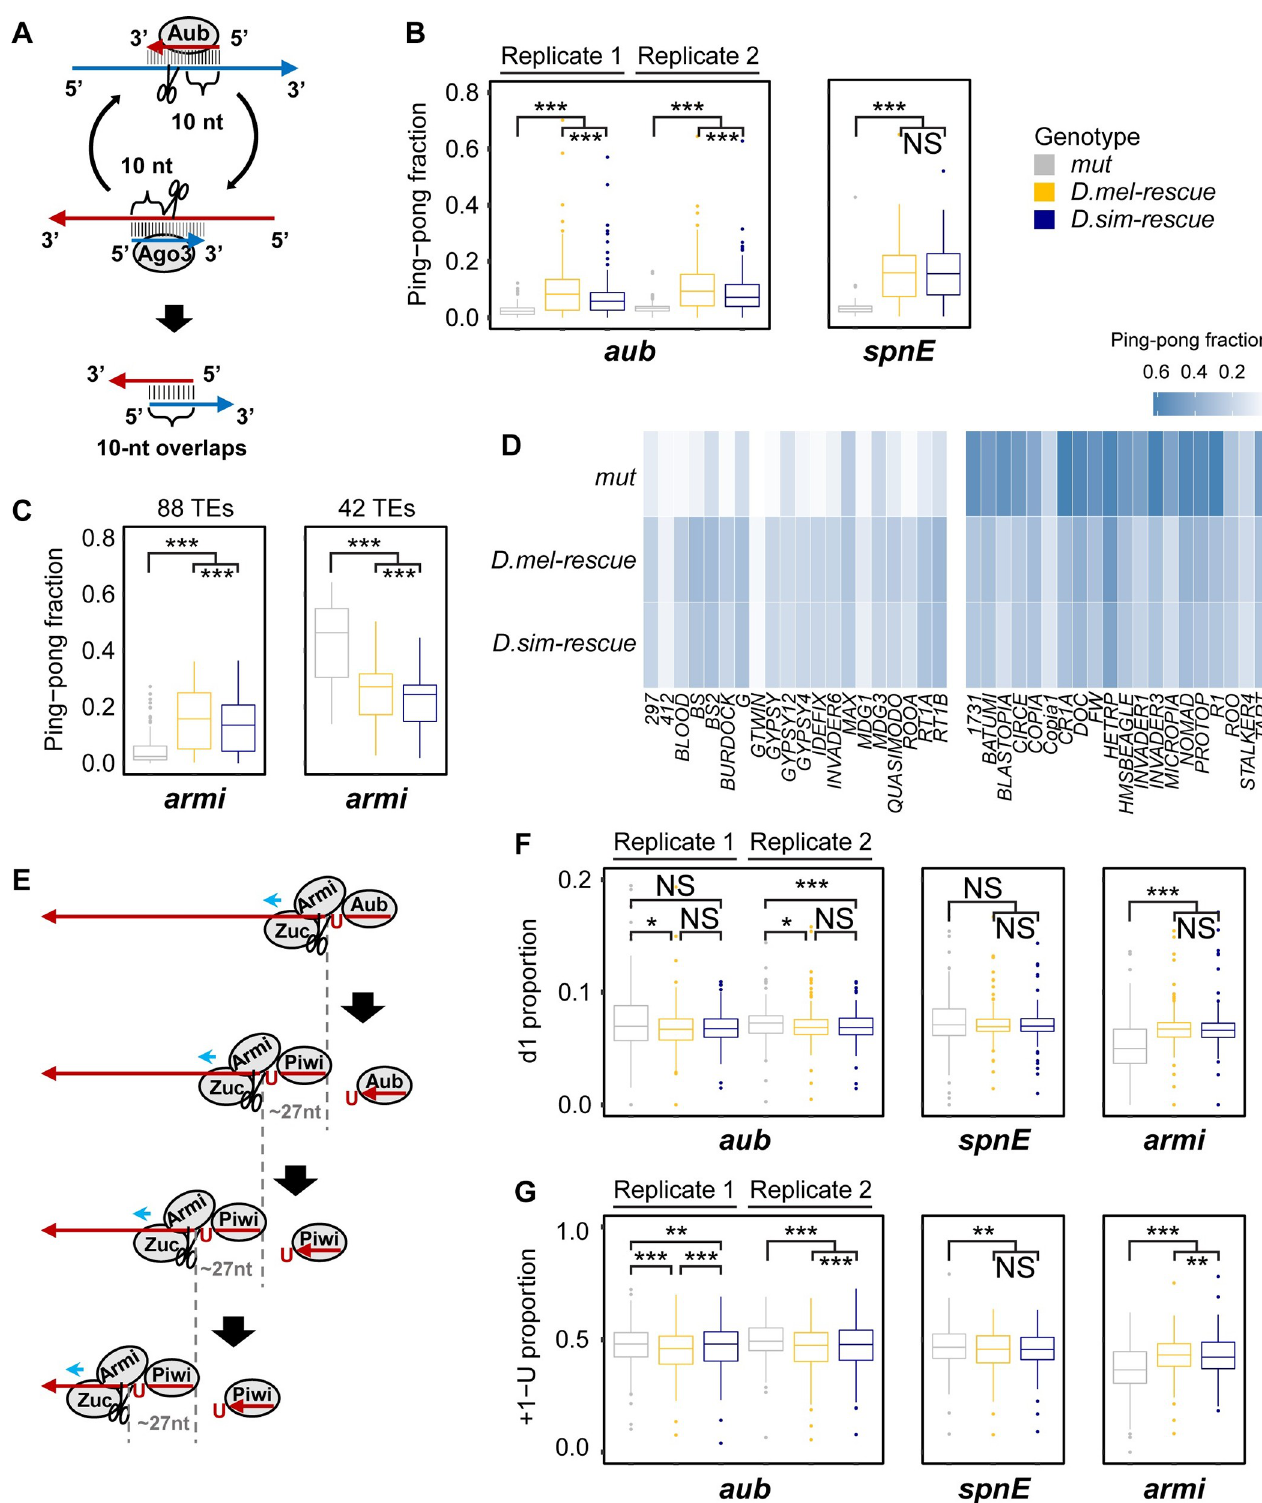
Fig 3. Drosophila simulans alleles reduce ping-pong biogenesis and phasing biogenesis. (A) Simplified diagram of ping-pong amplification loop. (B) Ping- pong fractions of TE-derived piRNAs from 142 TE families are compared between trans-heterozygous mutants and transgenic rescues for aub and spn-E . (C) Ping-pong fractions of TE-derived piRNAs are compared between trans-heterozygous mutants and transgenic rescues for armi . Comparison for 88 and 42